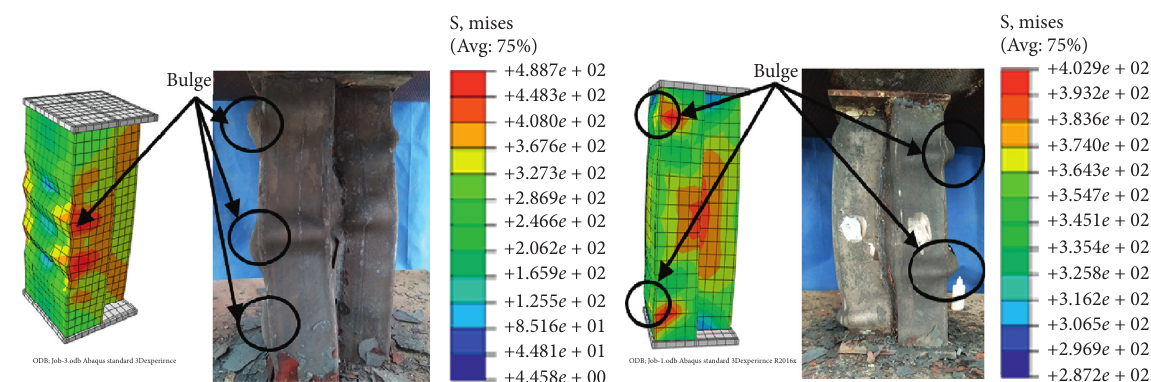
Figure 19: Comparison between FEA results and experimental values.